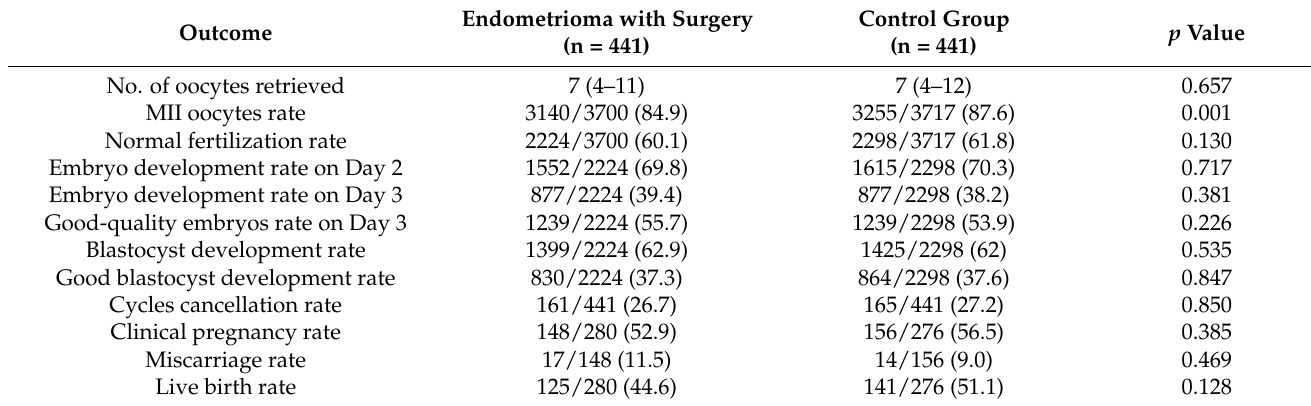
Table 3. Outcomes of the women with endometrioma who received surgery and the control group after